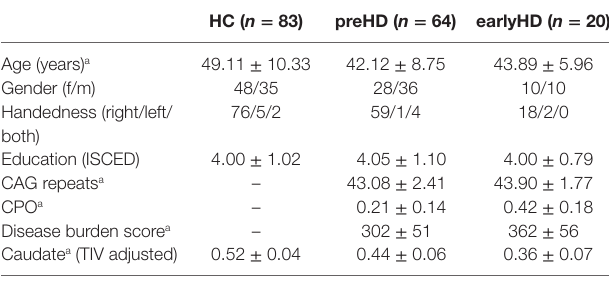
Table 1 | Demographic and clinical